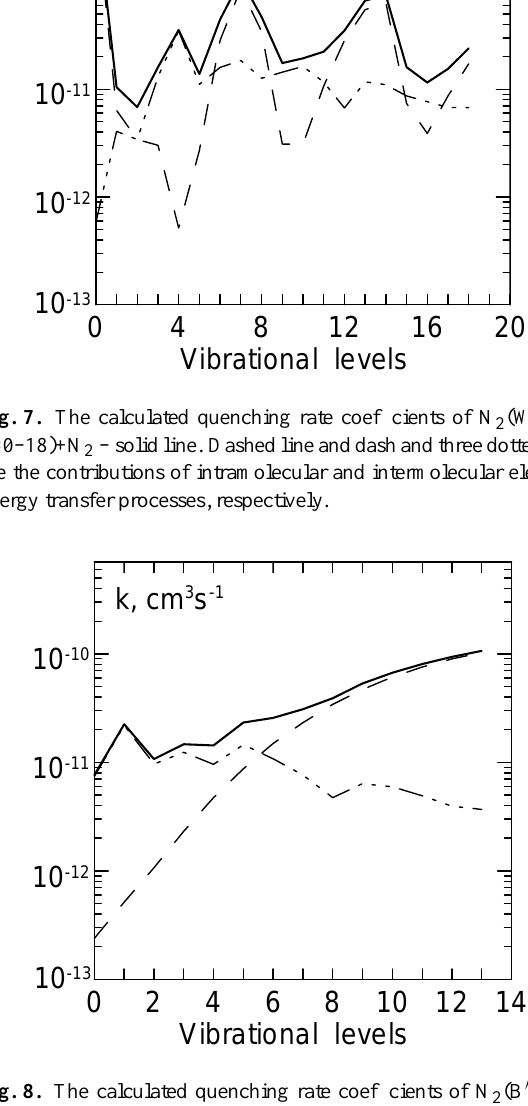
Fig. 8. The calculated quenching rate coefficients of N 2 (B 0 3 6 − u , v =0–13)+N 2 – solid line. Dashed line and dash and three dotted line Fig.8. are the contributions of intramolecular and intermolecular electron energy transfer processes, respectively.